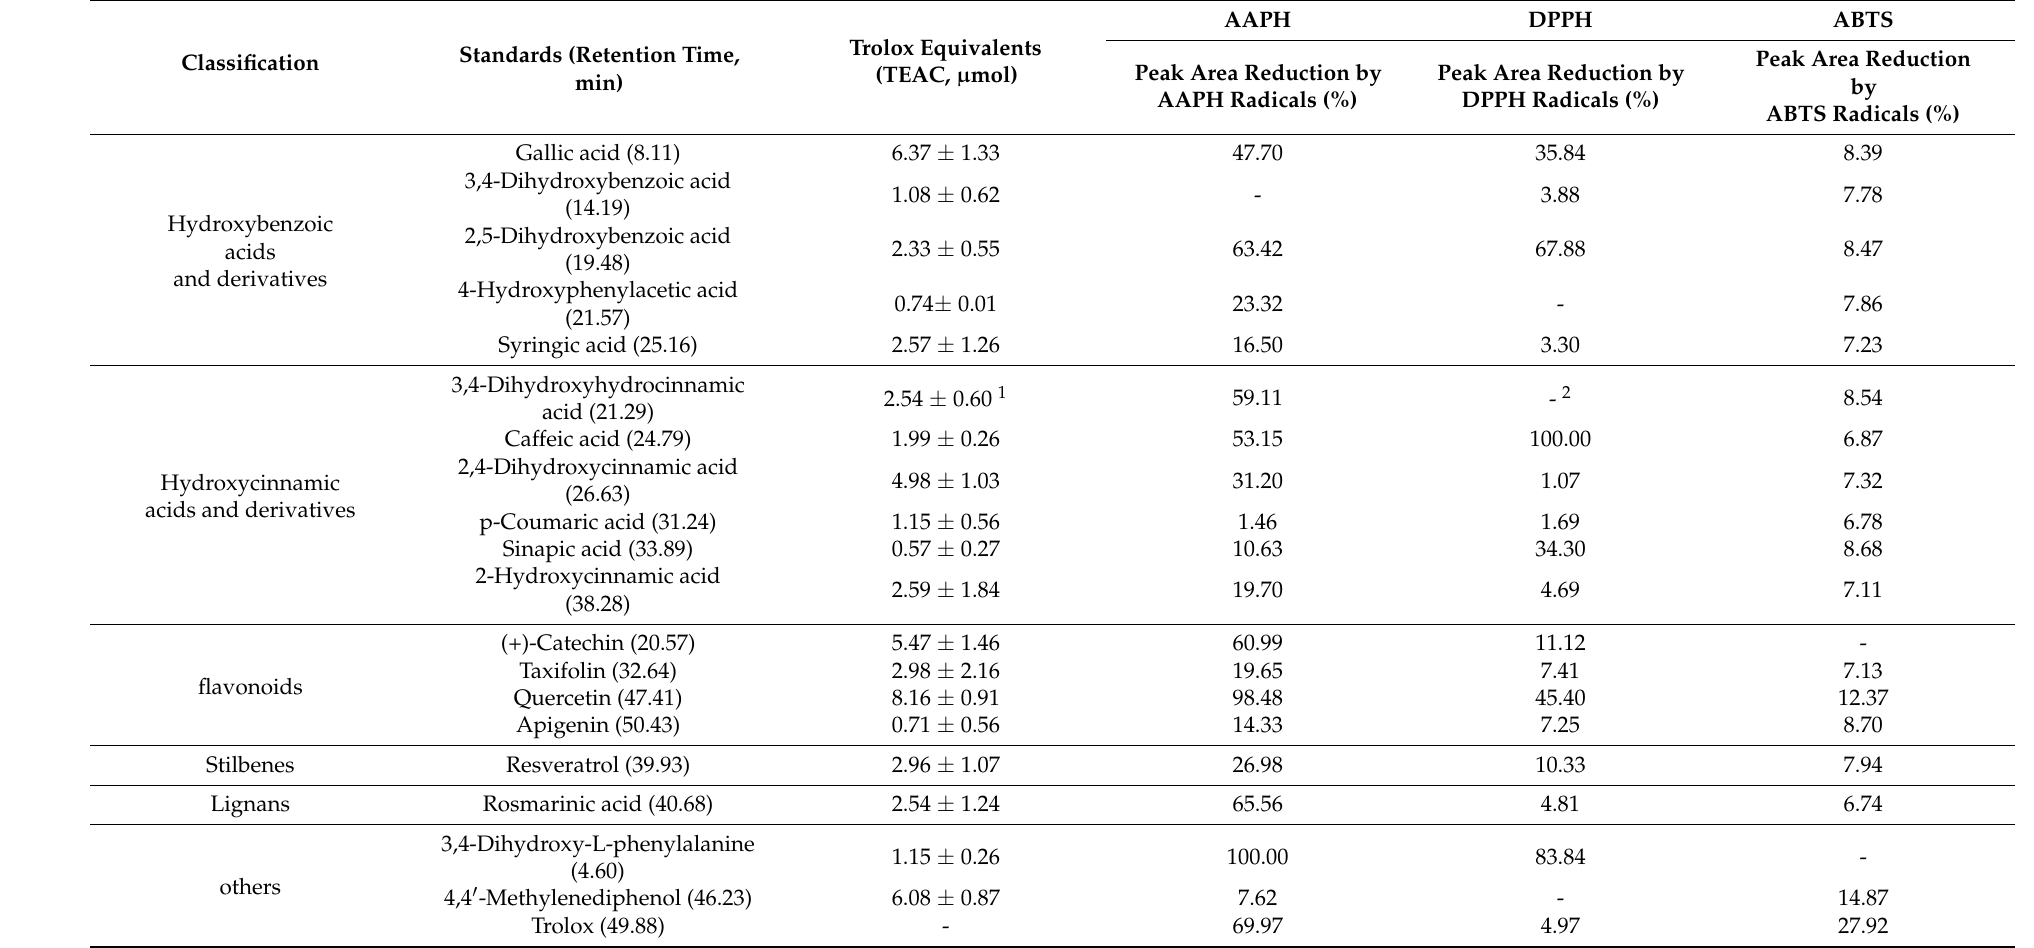
Table 2. Peak area reduction of polyphenols at different temperatures and results of screening antioxidants based on AAPH